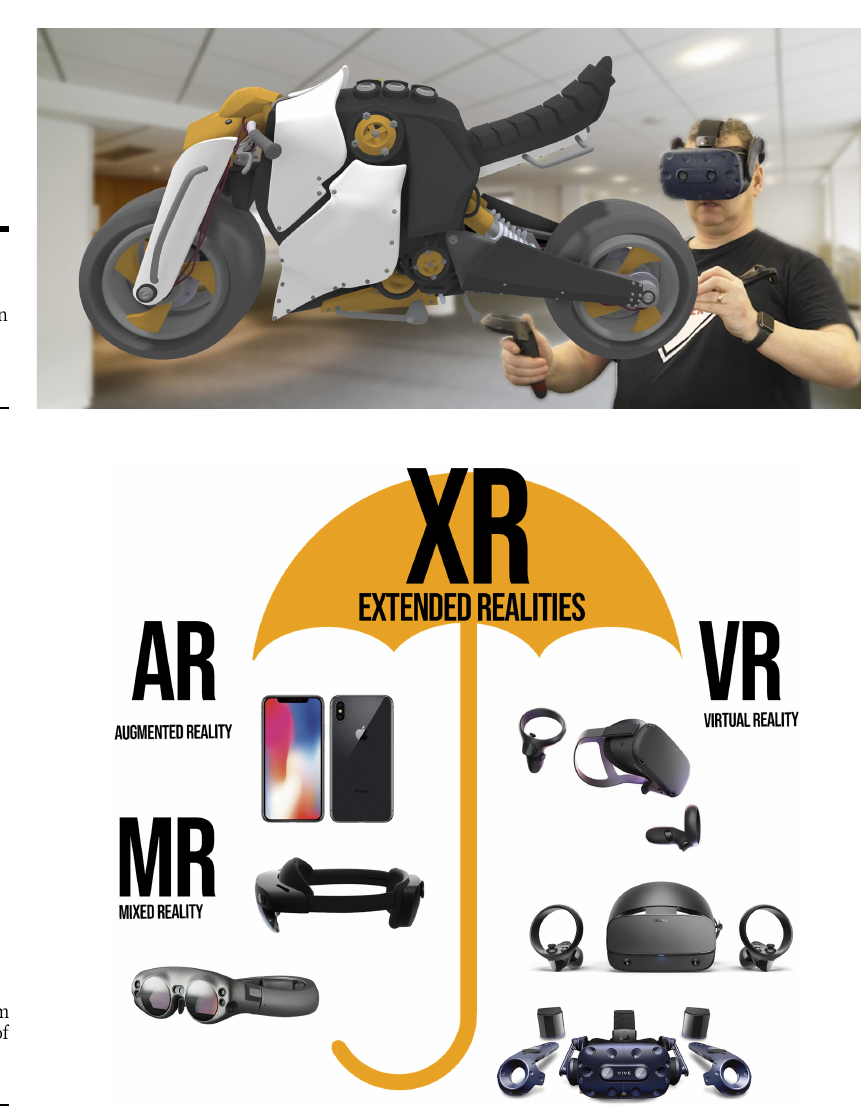
Figure 4. XR is an umbrella term that covers a variety of technologies that enhance our